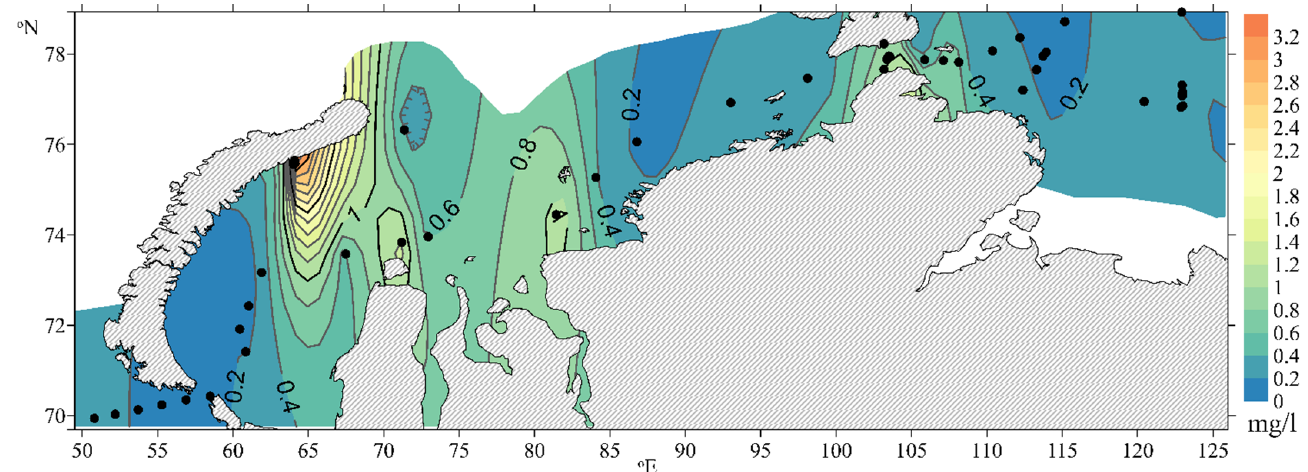
Figure 2. Distribution of suspended particulate matter (mg/L) in surface waters. The data were taken from the surface horizon using a Niskin bathometer, and the suspended matter concentration was measured by filtration.